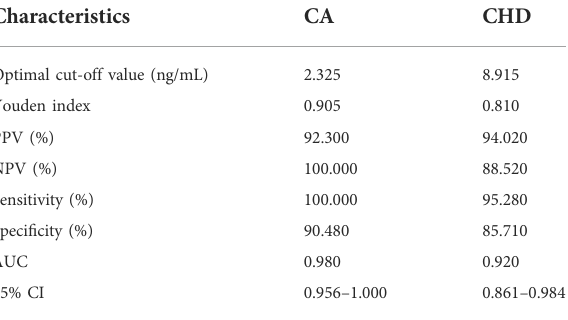
TABLE 1 Evaluation of the diagnostic ef fi cacy of